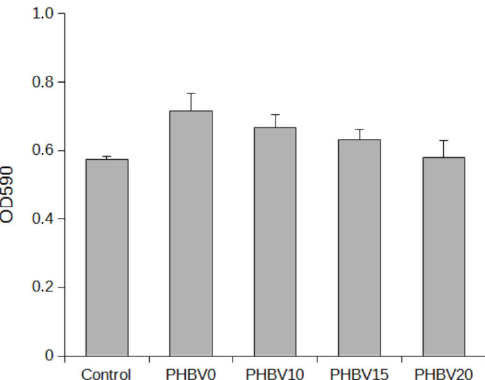
Figure 7. Graph representing the results obtained with L929 fibroblast cells in the evaluation of cytotoxicity of the modified PHBV fibrous mats. cytotoxicity of the modified PHBV fibrous